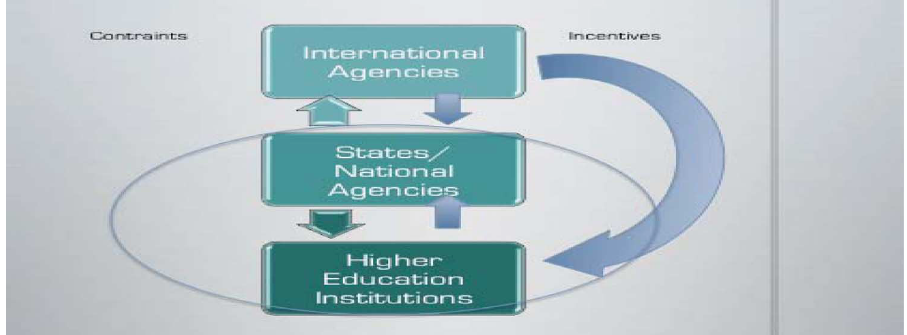
Figure 1. Scheme 1: inequalities’ indicators between national, international and local